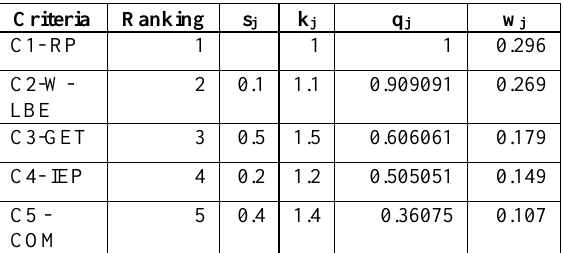
Table 5. SWARA Weighting Results for DM 3